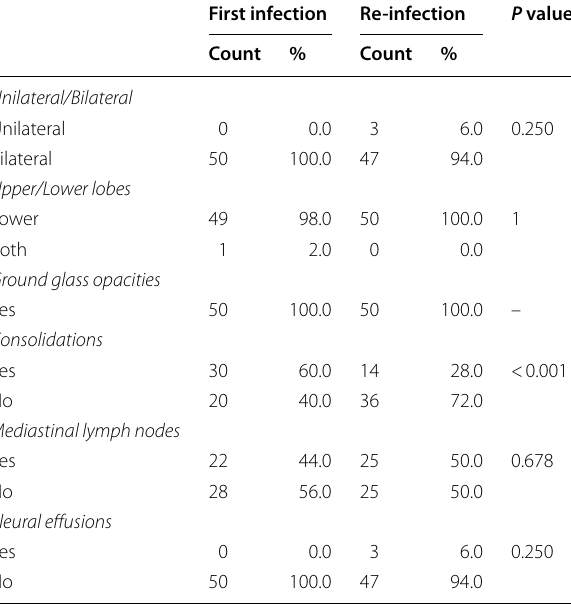
Respiratory distress